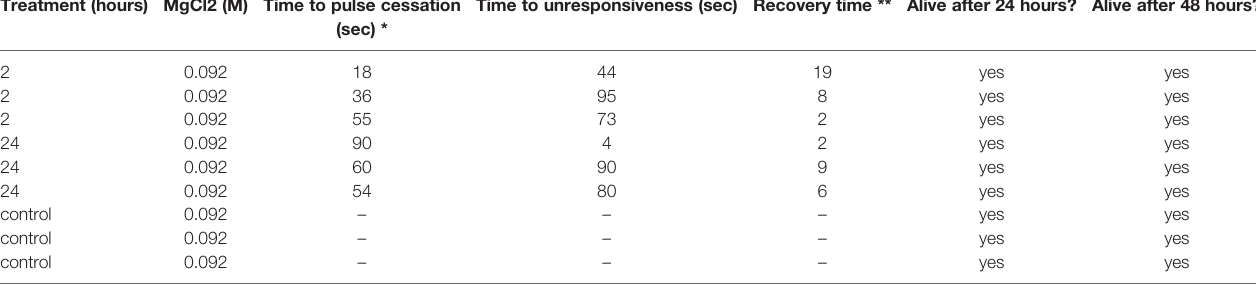
TABLE 1 | Summary of the main responses of Cassiopea sp.jelly fi sh to the MgCl 2 treatment ( e.g. , time to pulse cessation, time to unresponsiveness, recovery time, and survival). Treatment (hours) MgCl2 (M) Time to pulse cessation (sec)